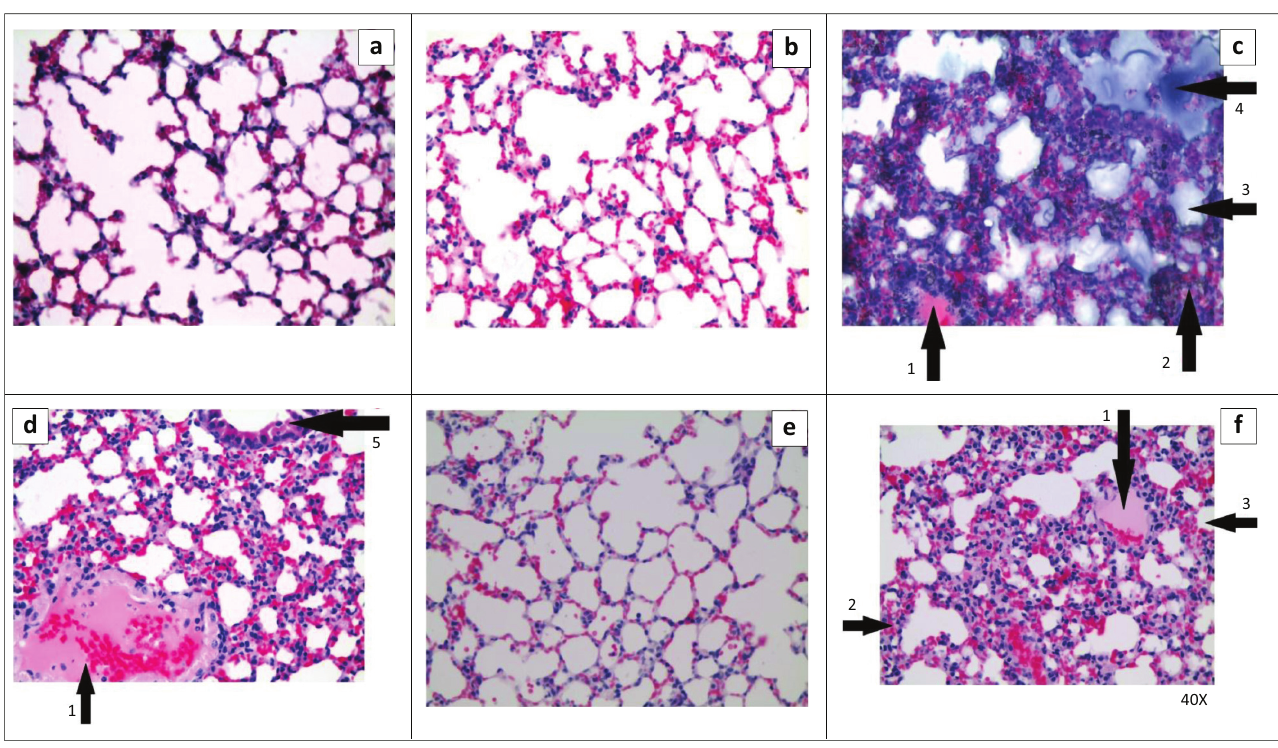
MDRSA, multidrug-resistant Staphylococcus aureus. FIGURE 5: Mouse lung tissue slides (40x magnification). Tissue from non-infected, non-treated mice (A) and phage-infected, non-treated mice (B) were well ventilated. Tissue from MDRSA-infected, non-treated control mice (C) had pockets of serous fluid (pneumonia) (1), lymphocyte-infiltrated (inflamed) septa (2), deflated alveoli (3) and alveoli full of mucus (4). Tissue from MDRSA-infected, clindamycin-treated mice (D) had pockets of pneumonia (1), inflamed septa and perivascular fibrosis of blood vessels (5). Tissue from MDRSA-infected, phage-treated mice (E) was well ventilated with resolved inflammation. Tissue from MDRSA-infected mice treated with a combination of clindamycin and phage (F) had pockets of pneumonia (1), inflamed septa (2) and deflated alveoli